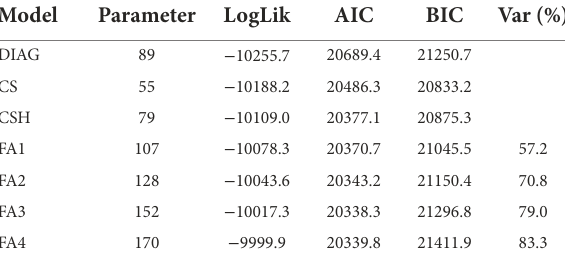
TABLE 2 Summary of the models fitted to the combined MET data